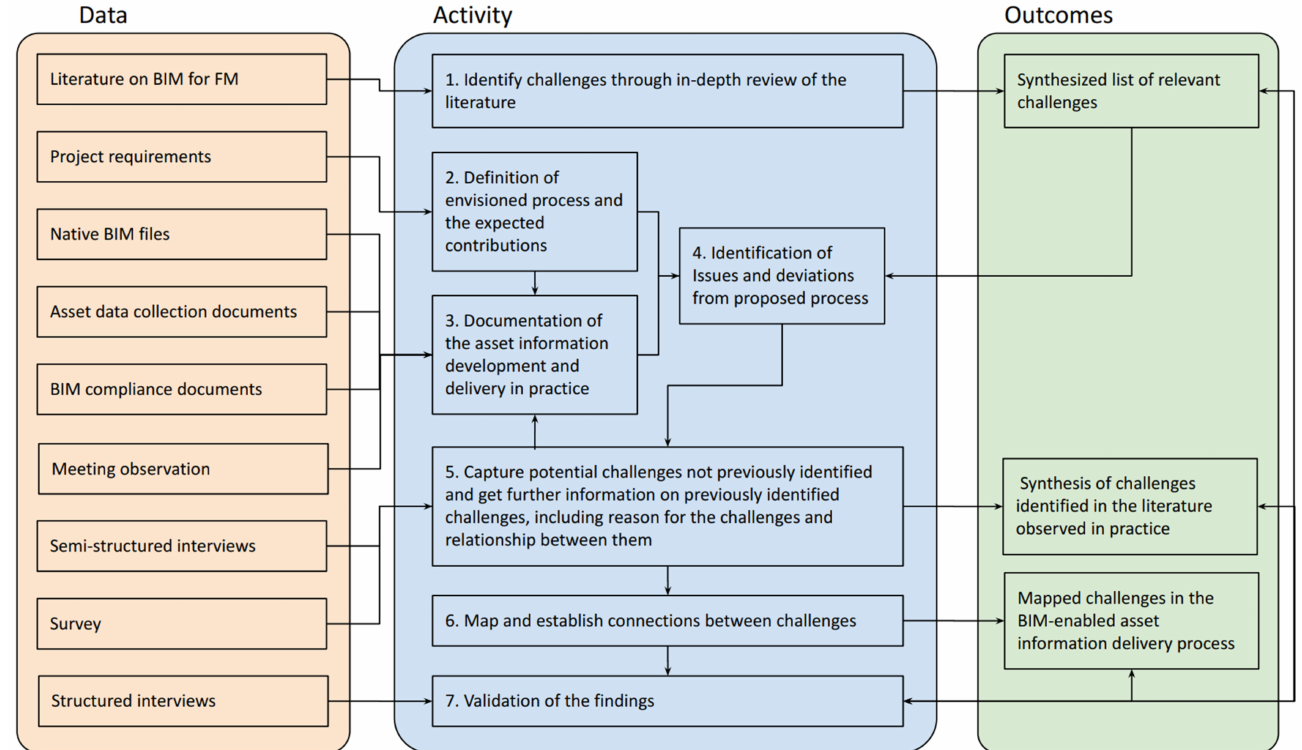
Figure 4. Mixed methods approach to identify and map the challenges in the BIM-enabled